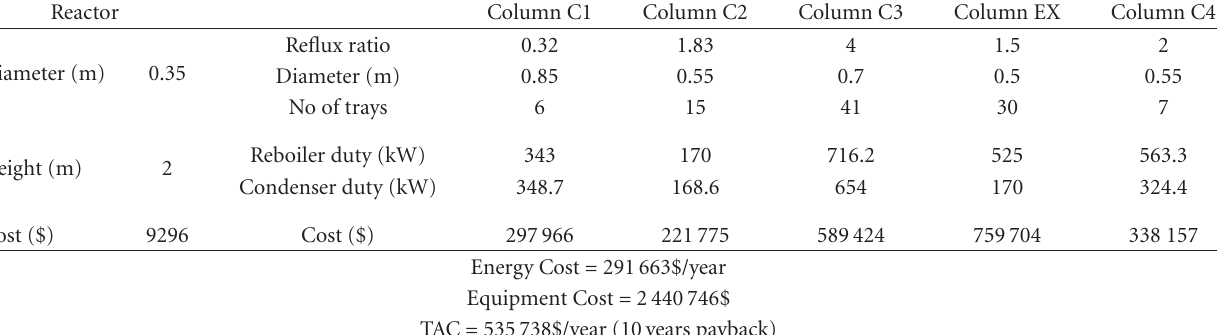
Table 5: Economic